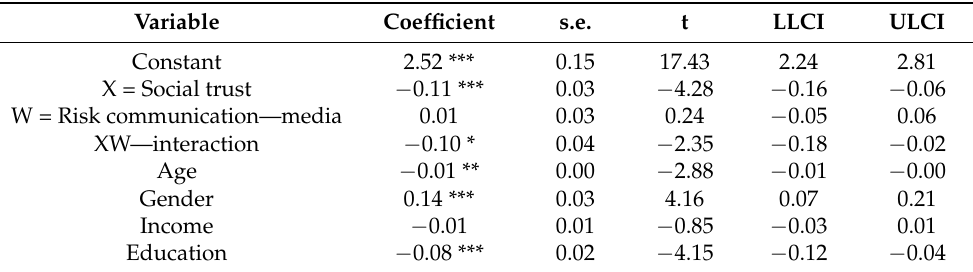
Table 3. A summary of the predictors of willingness to socialize with others; IV (X) = Social trust; Moderator (W) = Risk communication—media.